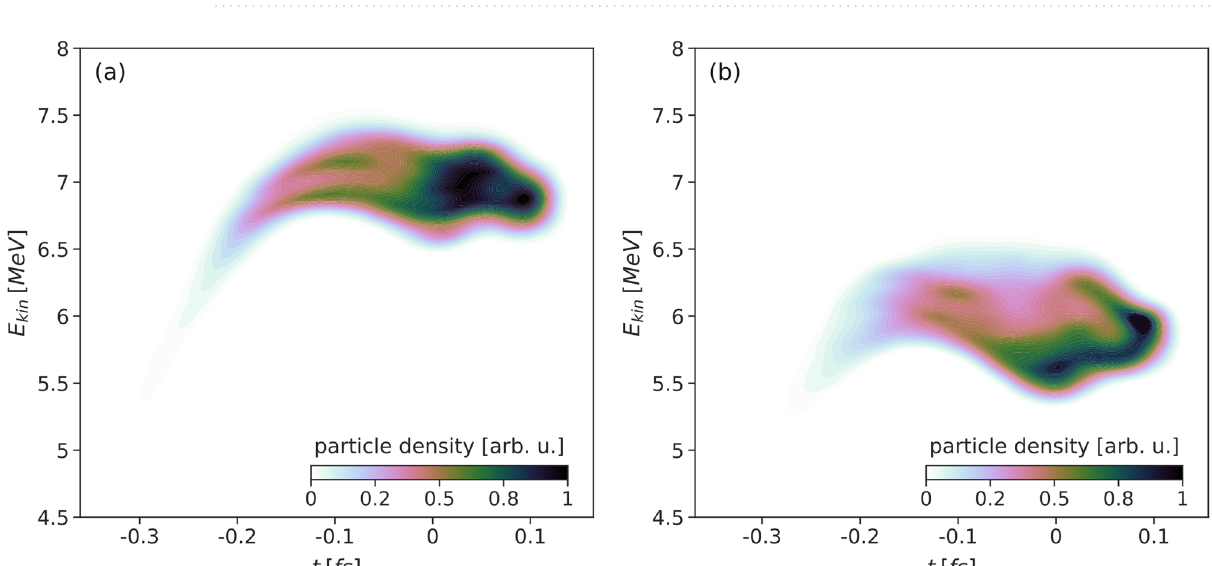
Figure 6. Longitudinal phase space: ( a ) before extraction, at t / T = 27, with the mean kinetic energy E kin = 6.94 MeV and FWHM energy spread (cid:31) E = 7.4 % and ( b ) after extraction, at t / T = 30 with the mean kinetic energy E kin = 5.77 MeV and FWHM energy spread (cid:31) E = 12.3 %